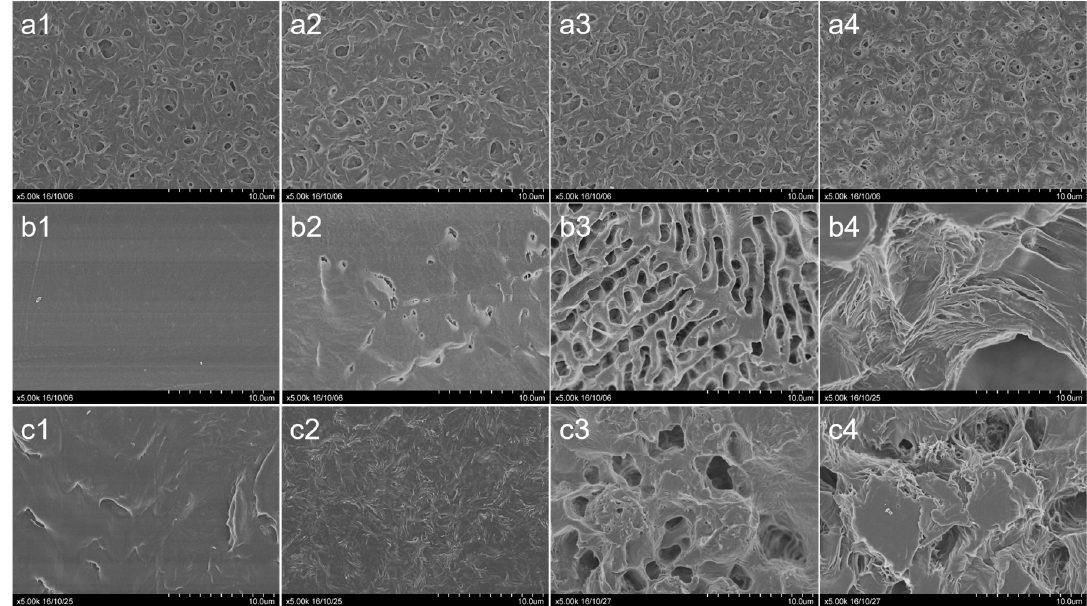
Figure 1. SEM images of the films (camphor contents before rinsing are given): ( a1 )—PHB (C0)